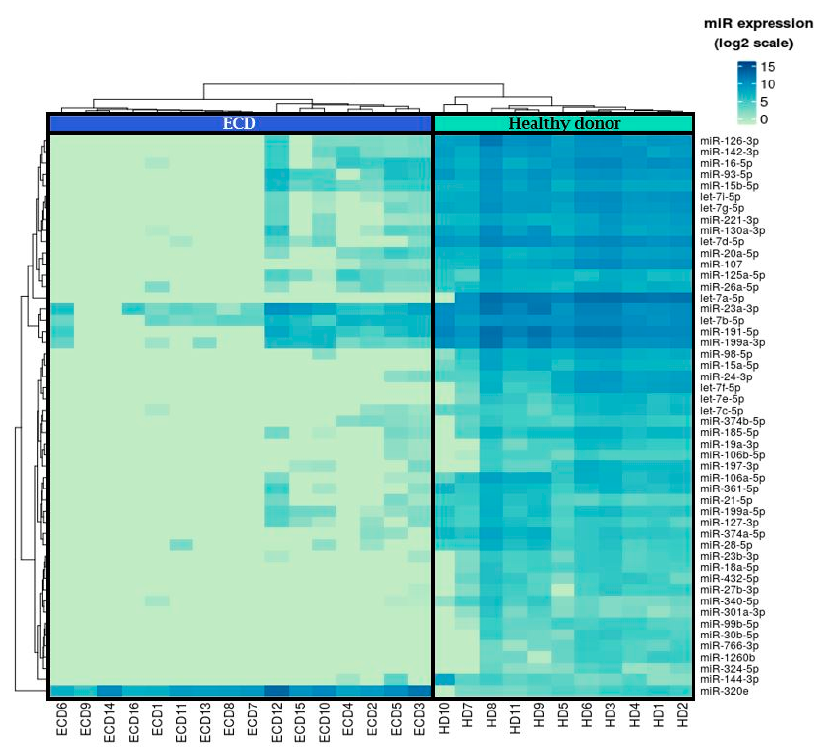
Figure 2. A heat map illustrating supervised clustering of the top 50 statistically significant miRNAs that were differentially expressed in samples from ECD patients as compared with samples from HC. Blue and green indicate the relatively high- and low-fold changes in miRNA expression, respectively.